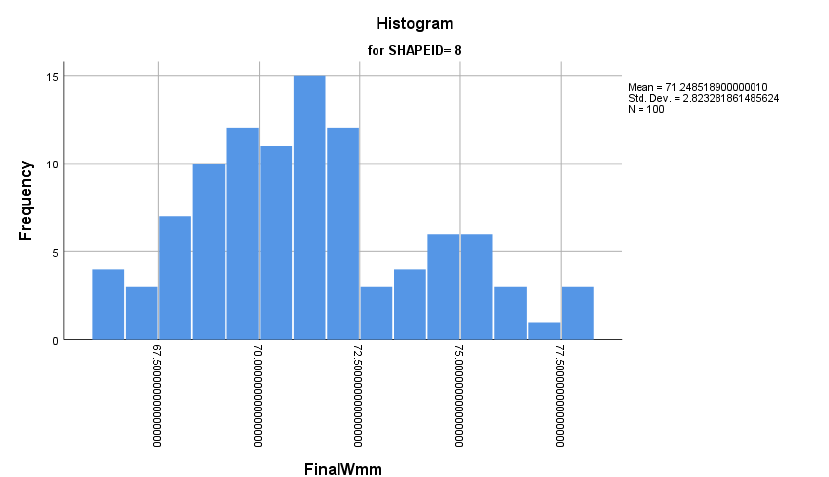
Figure A17. Shrink width adjustment for 70